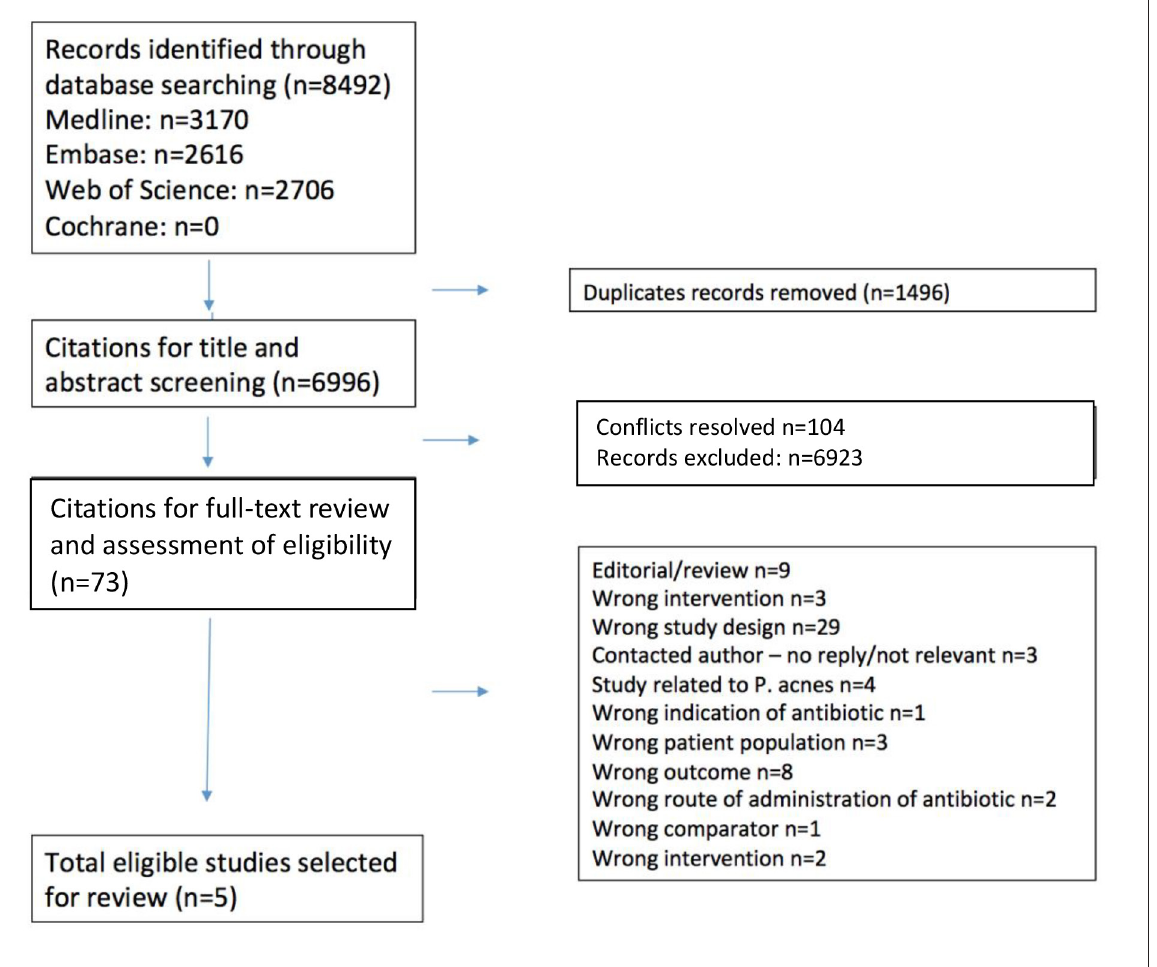
Figure 1 Flow diagram of study